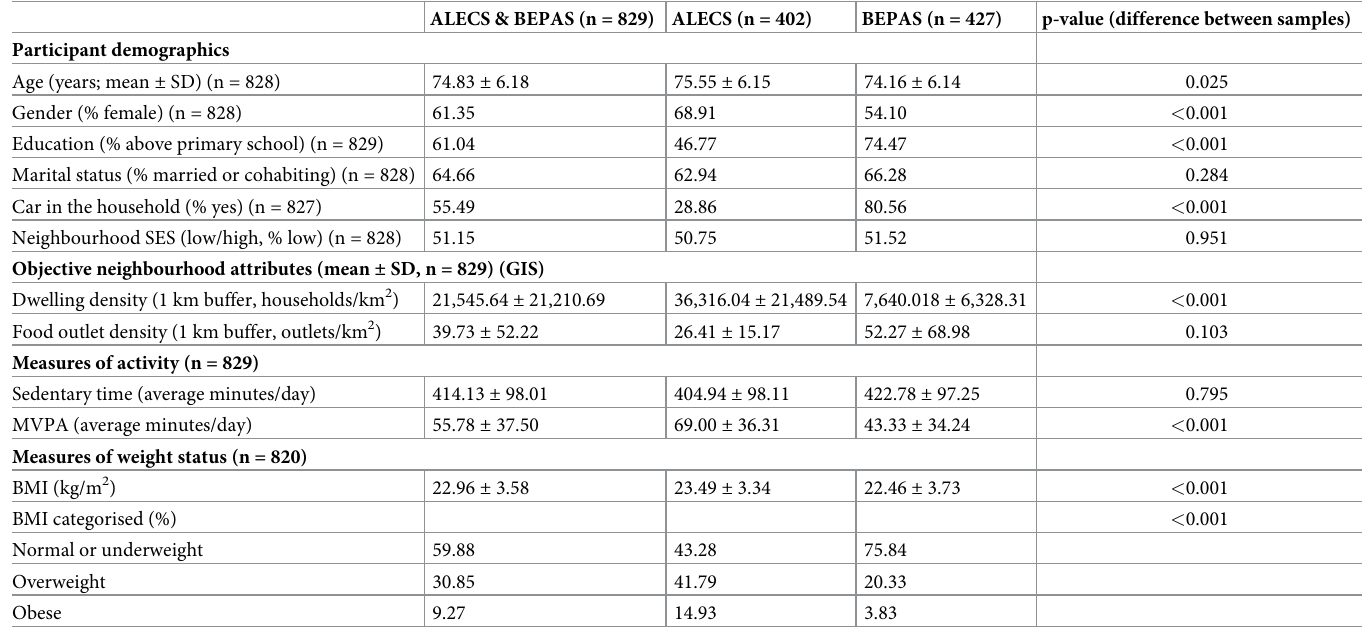
Table 1. Sample characteristics.